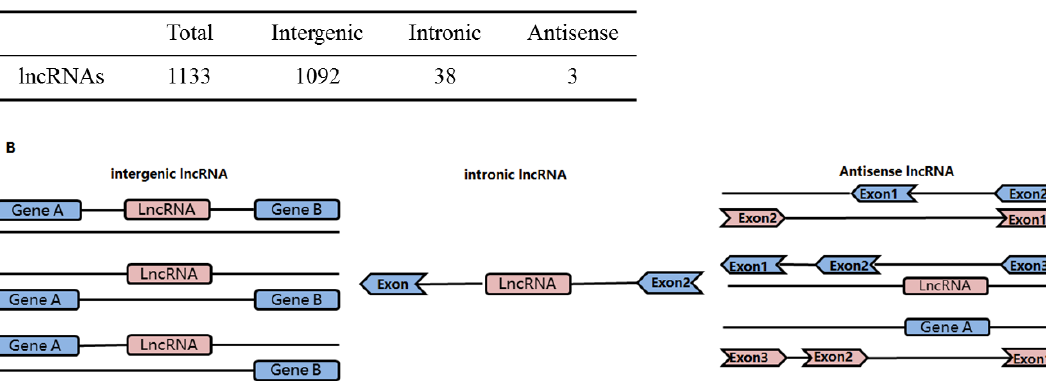
Figure 4. Classification of the predicted lncRNAs. ( A ) lncRNAs were classified as intergenic, intronic or antisense lncRNAs based on the spatial relationships of their gene loci with protein-coding genes; ( B ) Schematic illustration of the classification of lncRNA genes based on their spatial relationship with protein-coding genes.